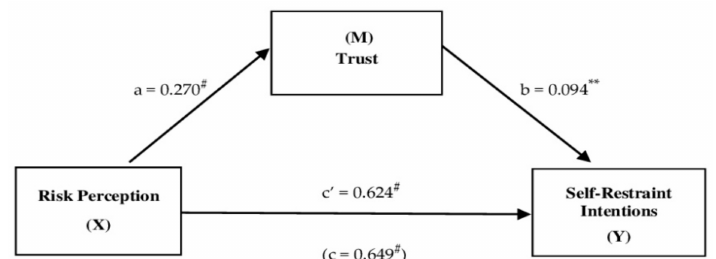
Figure 1. The mediating effect of trust in the relationship between risk perception and self-restraint intentions. Notes: # p < 0.0001; ** p < 0.001; all presented effects are standardized; a is effect of Risk Per- ceptions on Trust; b is effect of Trust on Self-Restraint Intentions; c’ is direct effect of Risk Perceptions on Self-Restraint Intentions, c is total effect of Risk Perceptions on Self-Restraint